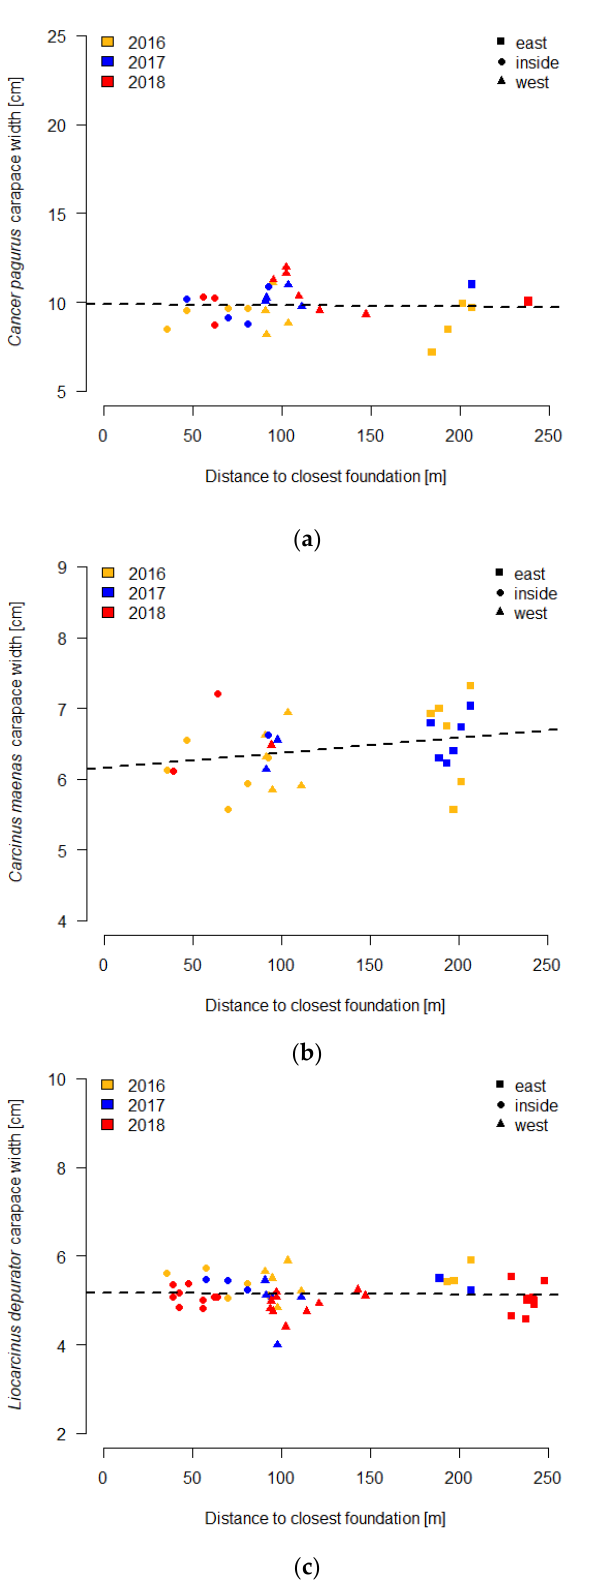
Figure 7. Average carapace width per decapod species: ( a ) Cancer pagurus , ( b ) Carcinus maenas , and ( c ) Liocarcinus depurator captured with small cages in 2016 – 2018. Black dashed line represents a pooled regression line for all years.